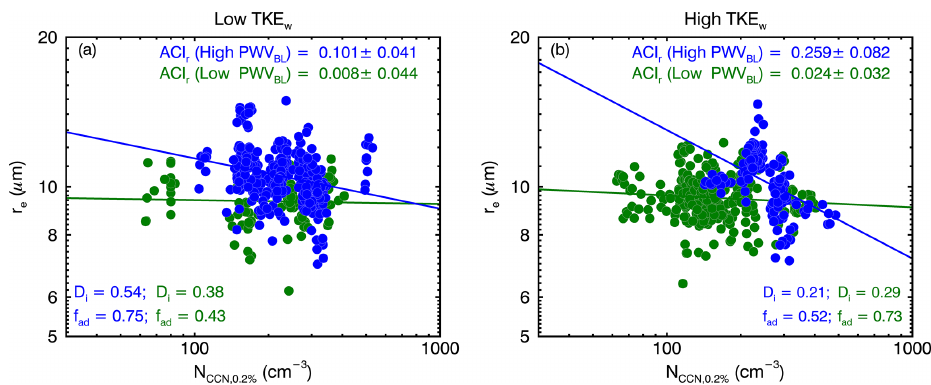
Figure 7. ACI r derived from r e in relation to N CCN , 0 . 2% for (a) low-TKE w and (b) high-TKE w regimes. Samples in the low-PWV regime are plotted in green, and samples in the high-PWV regime are plotted in blue. The mean values of D i and f ad are displayed for each quadrant with the corresponding color